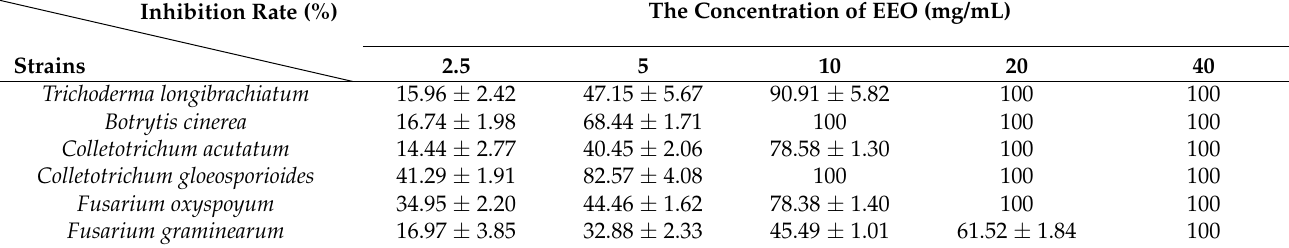
Table 3. Antifungal activity of